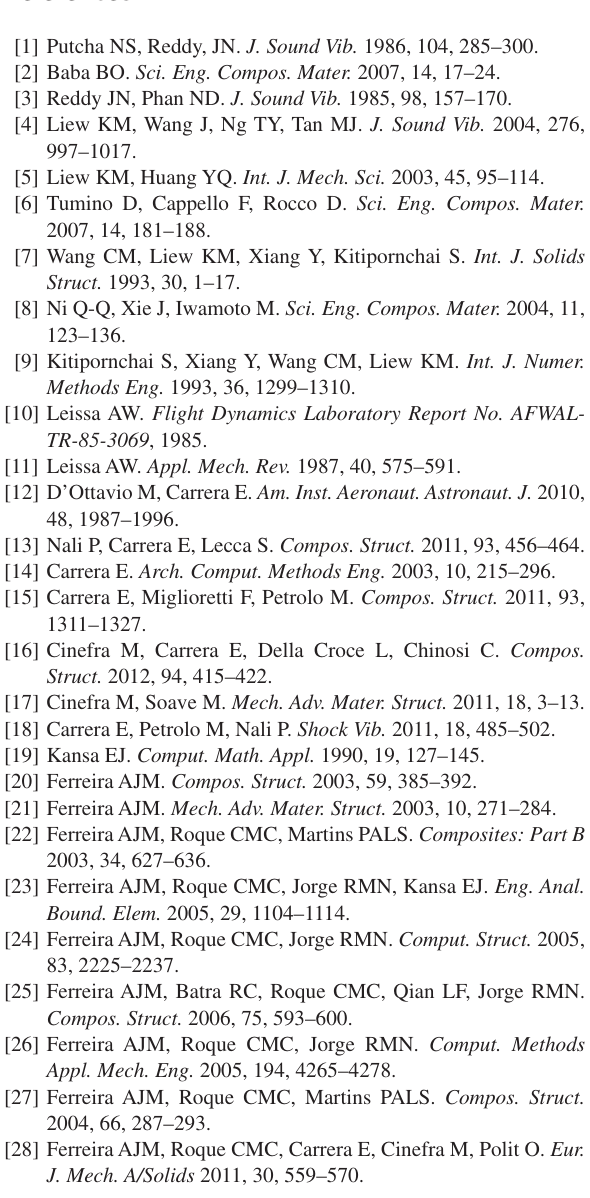
Figure 7 First four buckling modes for a bi-axial buckling load of three-layer [0/90/0] SSSC laminated plate, using a 17 2 points grid and the higher-order theory.